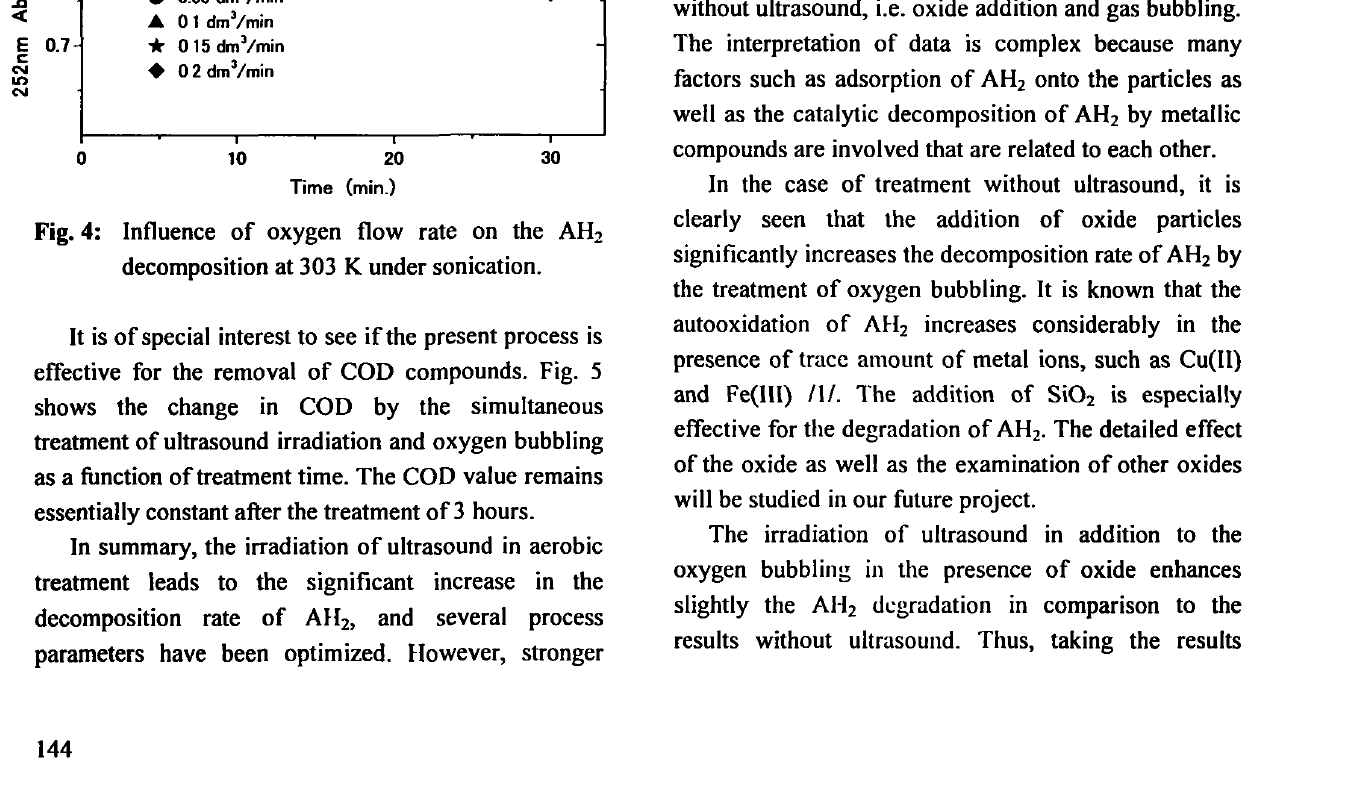
Fig. 5: COD change at 313 K. with different oxygen flow